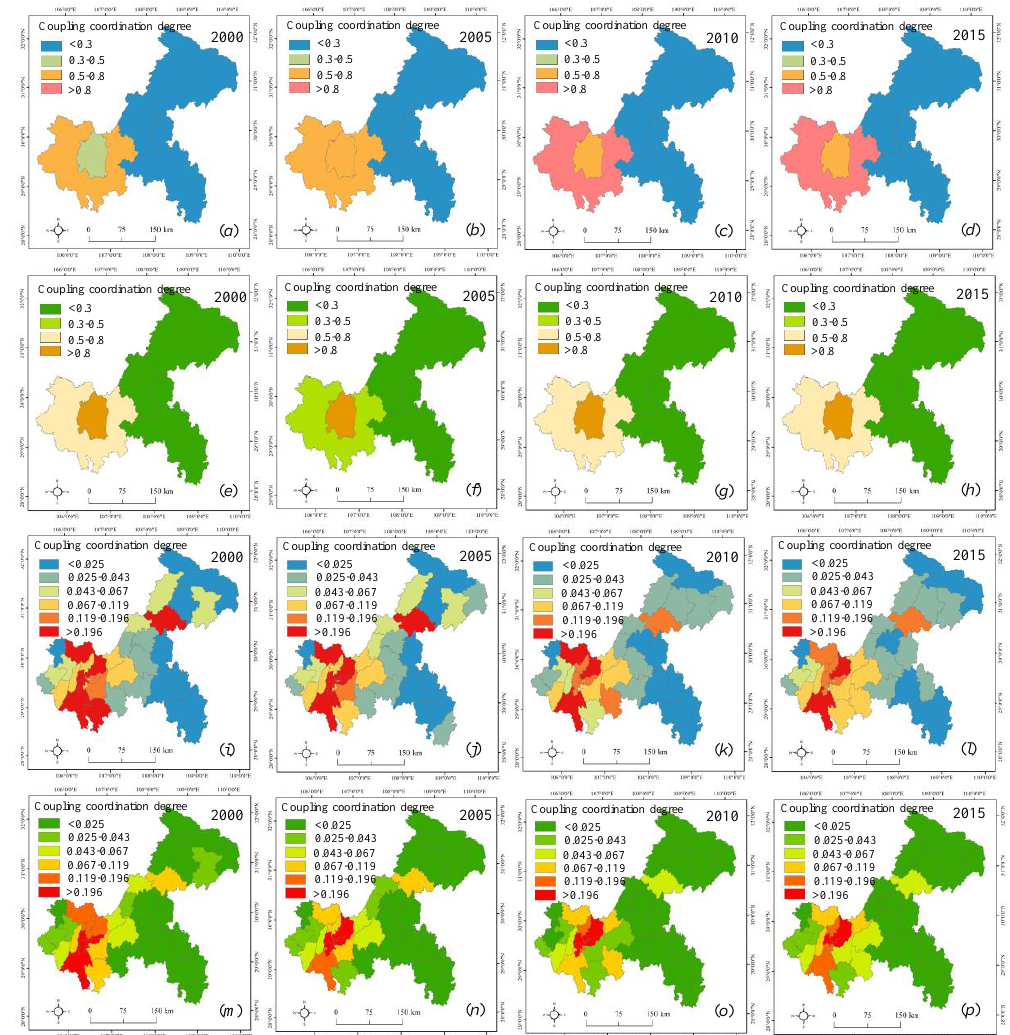
Figure 7. The coupling coordination degree between urban land and carbon emissions at different scales. Note: ( a )–( d ) the coupling coordination degree between urban land and total carbon emissions at the regional scale; ( e )–( h ) the coupling coordination degree between urban land and carbon emission intensity at the regional scale; ( i )–( l ) the coupling coordination degree between urban land and total carbon emissions at the county scale; ( m )–( p ) the coupling coordination degree between urban land and carbon emission intensity at the county scale.